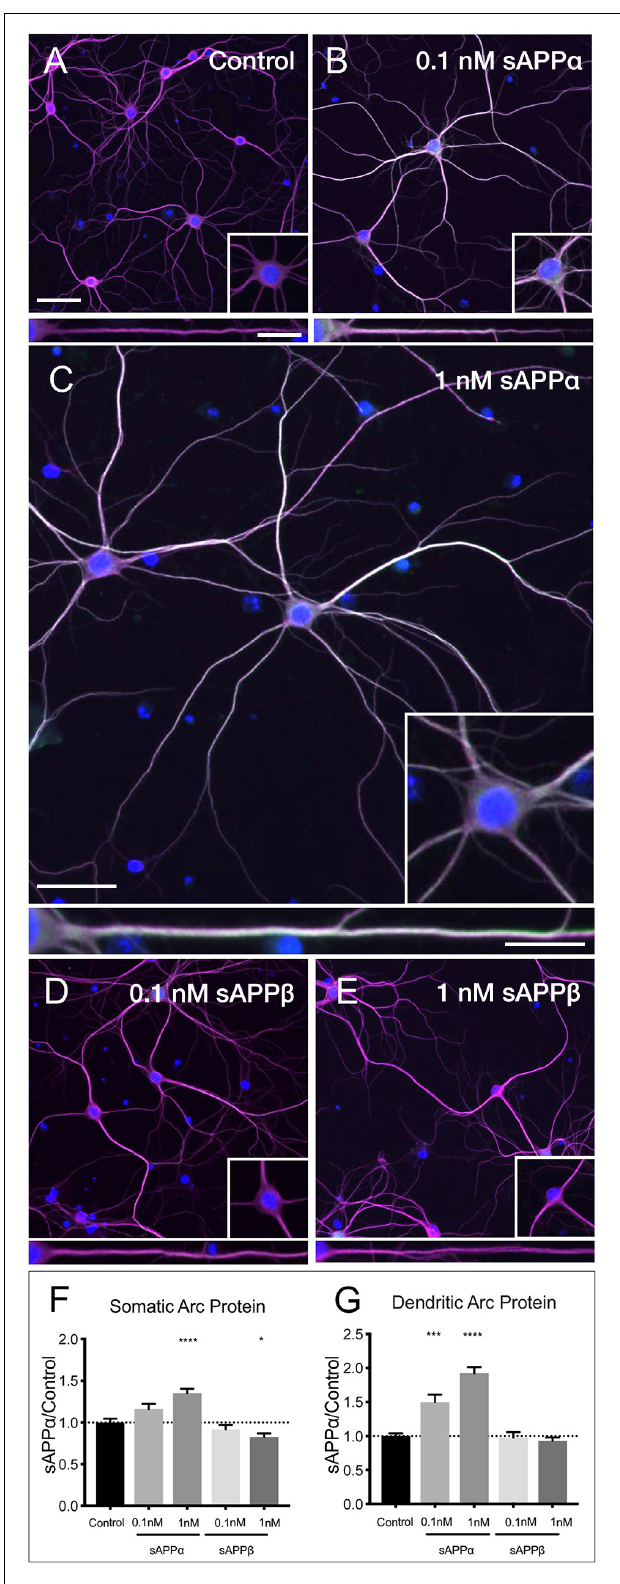
FIGURE 4 | sAPP α promotes Arc protein expression in a concentration- dependent manner. Representative images showing Arc protein levels in (A) no drug control, (B) 0.1 nM sAPP α , (C) 1 nM sAPP α , (D) 0.1 nM sAPP β and (E) 1 nM sAPP β -treated primary hippocampal neurons. (F) Average data showing 1 nM sAPP α promotes an increase, and 1 nM sAPP β a modest decrease in Arc protein expression in the somata. (G) Average data showing 0.1 and 1 nM sAPP α promotes an increase in dendritic Arc protein. Data are expressed as mean ± SEM from ≥ 4 experiments. 0.1 nM: n = 40 cells; 1 nM: n = 80 cells. Significance was calculated using a Kruskal–Wallis one-way ANOVA with Dunn’s multiple comparisons test. ∗ p = 0.0378, ∗∗∗ p = 0.0002, ∗∗∗∗ p ≤ 0.0001. Representative images show neuronal somata and dendritic projections (MAP2; magenta), Arc protein (green), nuclei (DAPI; blue), (scale bar = 50 µ m), and magnified somatic (inset, bottom right) and dendritic (100 µ m; lower panels; scale bar = 10 µ m) compartments.